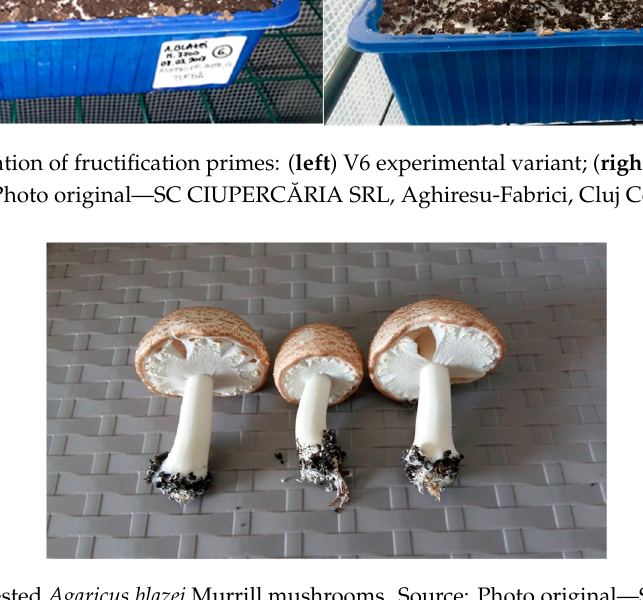
Figure B6. Harvested Agaricus blazei Murrill mushrooms. Source: Photo original—SC CIUPERC Ă RIA SRL, Aghiresu-Fabrici, Cluj